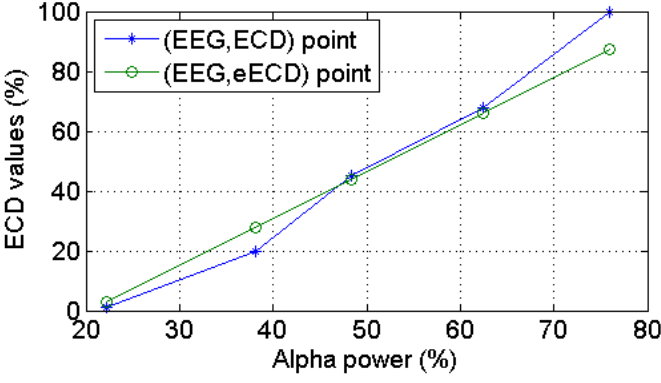
Figure 14. Five observed (EEG,ECD) points from subject #12 and corresponding estimated (EEG,eECD) points by using LSVR.